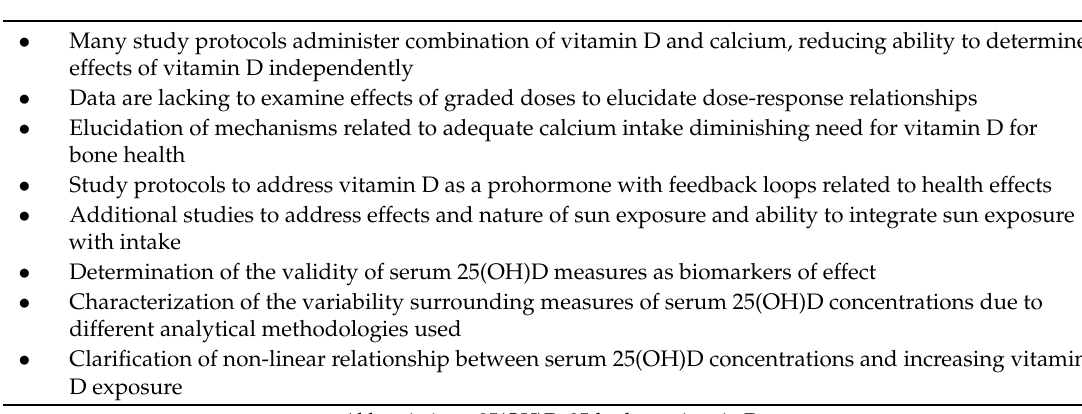
Table 2. Notable evidence gaps for vitamin